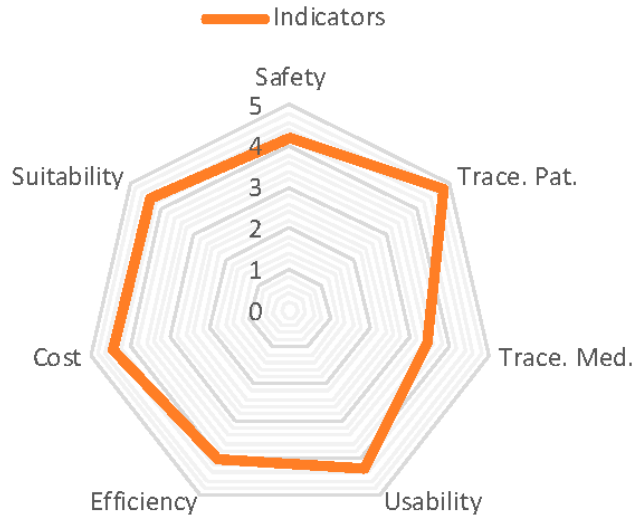
Figure 4. Global values of the analysed indicators with a radial graphic.